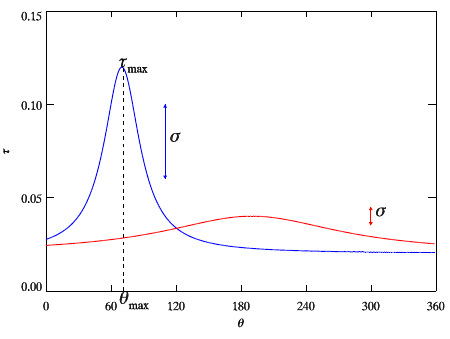
Fig. 1. (a) . Definition of wind direction. (b) . AOD (indicated by the circles) are categorized by wind direction. Fig. 2. For each 1